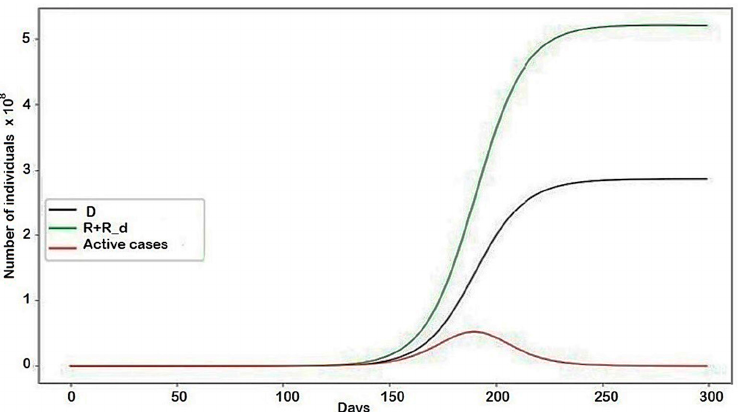
Figure A2. The modeling results describing the behaviors of the system in general. The conflict is given by the following parameters: a 1 = − 0.4, a 3 = − 0.2, b 1 = 0.3, b 2 = 0.2, b 3 = − 0.05, b 4 = 0.05, c 1 = 0.45, c 2 = 0.23, c 3 = − 0.1, c 4 = 0.1, d 1 = 0.4, d 2 = − 0.4, the rest are equal to zero.